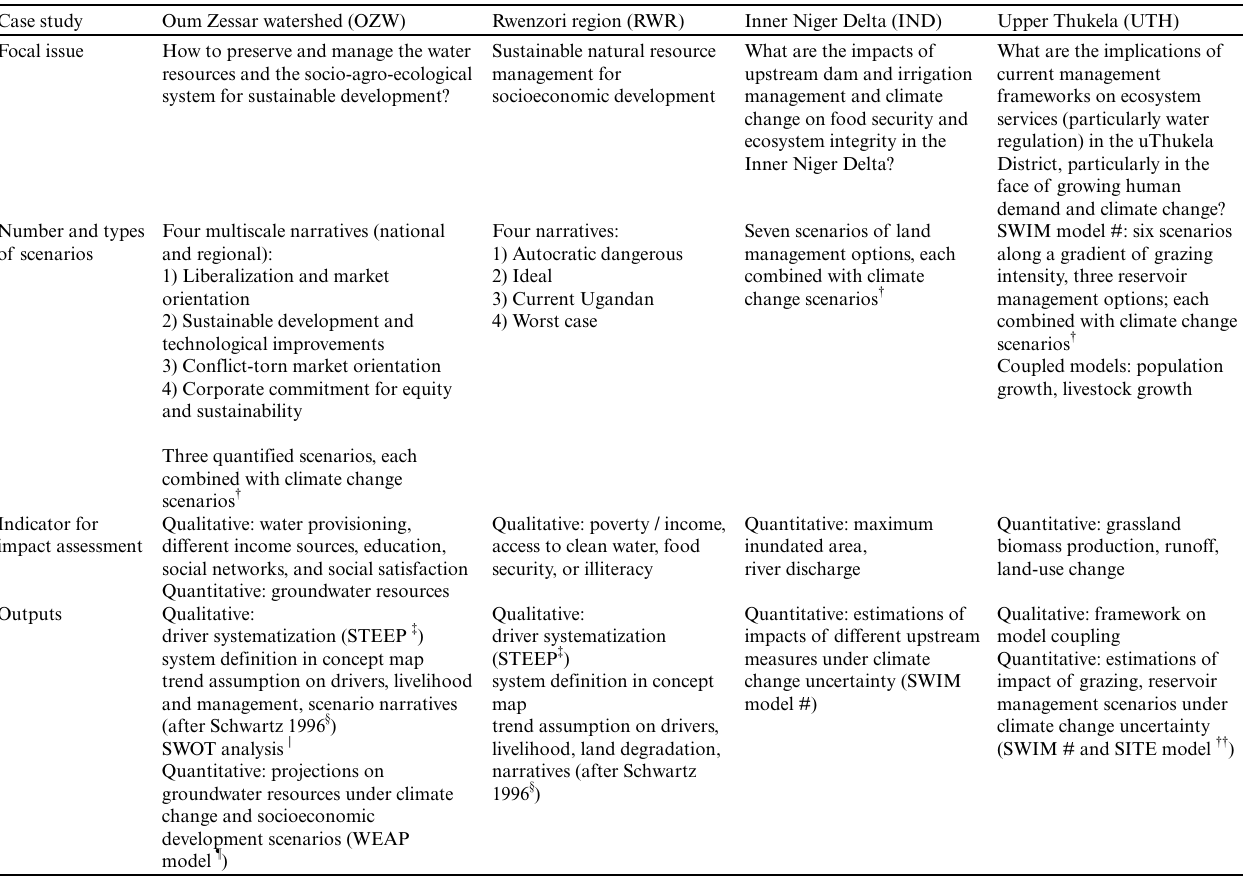
Table 1 . Summary of the outcomes of the four scenario